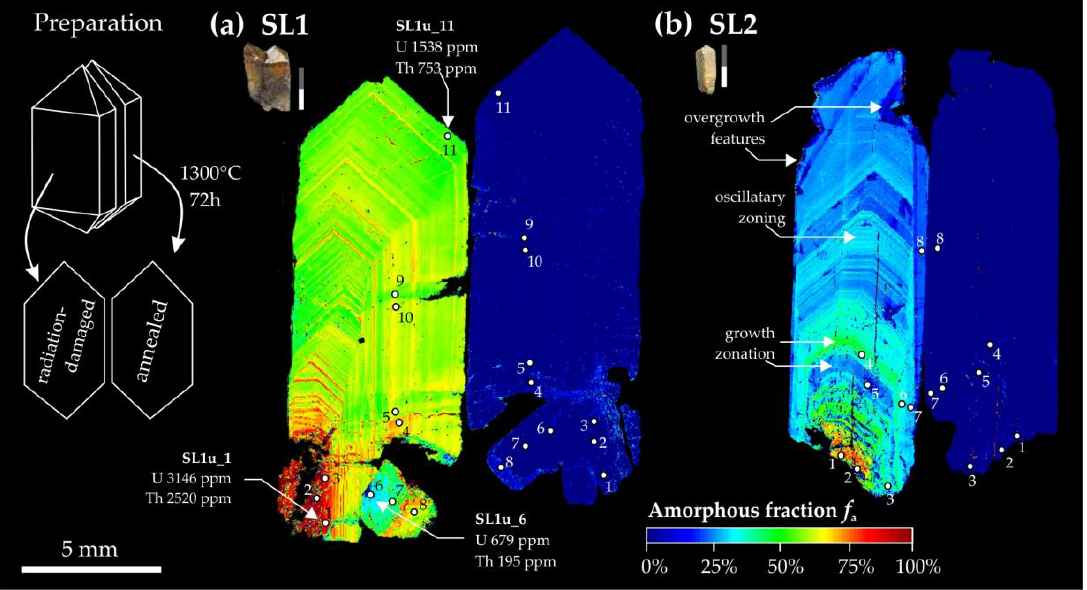
Figure 4. Photoluminescence hyperspectral maps of two large, heterogeneous Sri Lankan zircon single-crystals, SL1 ( a ) and SL2 ( b ). The crystals were cut in halves, with one half left in the original, radiation-damaged state and the other half annealed at 1300 °C for 3 days (see inset sketch). Mapping parameter is the amorphous fraction f a as determined with the PL method (cf., Figure 3b) using a software-based least-squares fitting applied to a point-by-point scanned data-set. Radiation damage is detected in the original halves (left) with high f a in zones with elevated U and Th concentrations (cf., Table A2 in Appendix A). The annealed halves (right) fully recovered crystallinity and show no amorphous component. Pairs of LA-ICP-MS analyses-spots on each half are indicated.